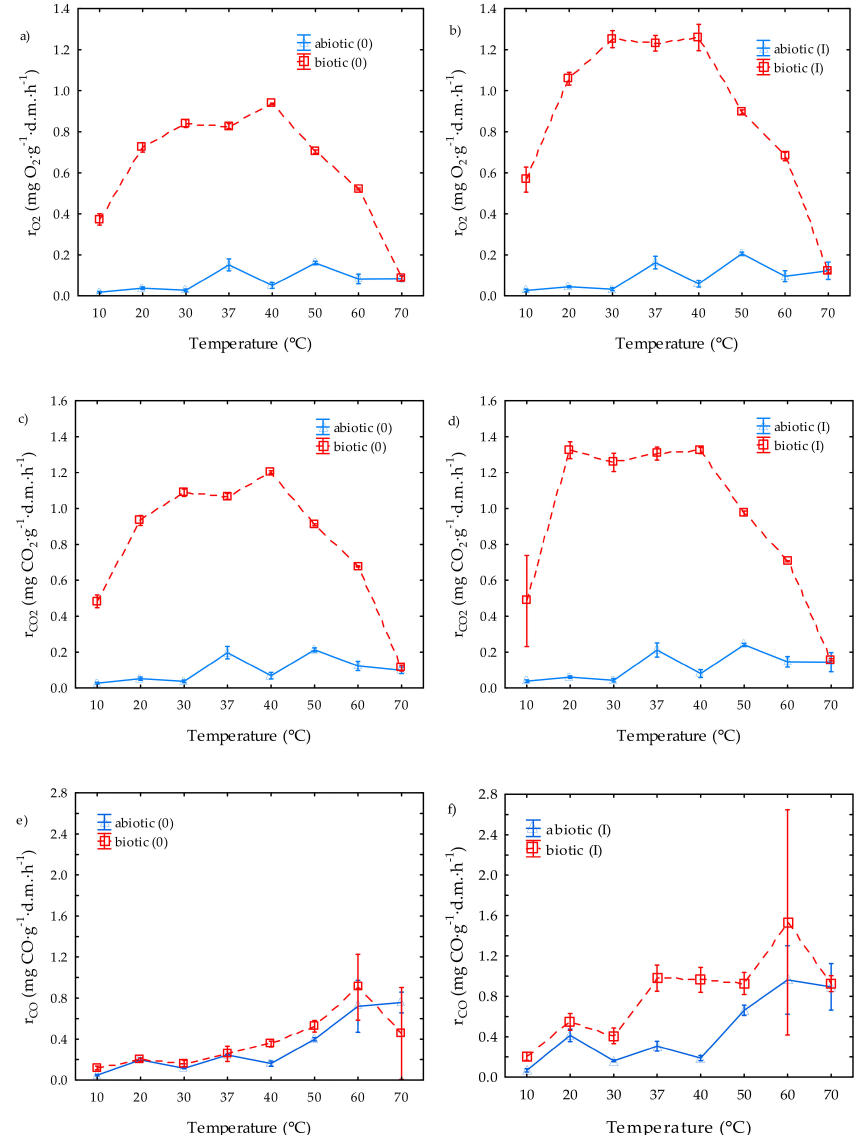
Figure A1. Average production and consumption rate ( r O2 ) ( a ) O 2 consumption 0-order kinetic, ( b ) O 2 consumption I-order kinetic, ( c ) CO 2 production 0-order kinetic, ( d ) CO 2 production I-order kinetic, ( e ) CO production 0-order kinetic, ( f ) CO production 0-order kinetic. The error bars are showing +/ − standard deviation around the mean. The kinetic values are shown in Tables S2.1–S2.3 (Supplementary Materials, sheets